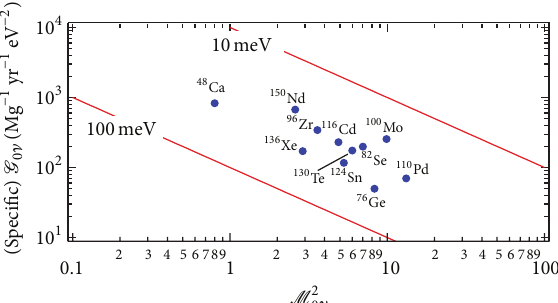
Figure 14: Geometric mean of the squared M 0 ] considered in [197] versus the specific 𝐺 0 ] . The case 𝑔 𝐴 = 𝑔 from